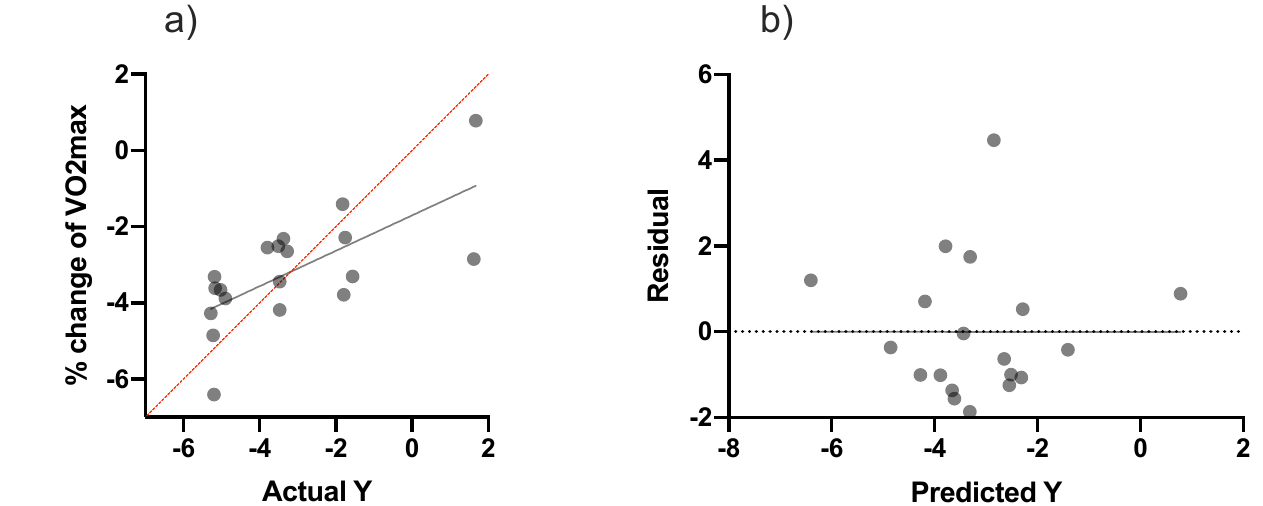
Figure 2. Multiple linear regression analysis was calculated to predict the percentage of change in fitness levels ( a ) VO 2max based on accumulated workloads. and PHV in the soccer players. Also. ( b ) residual plot was calculated to predict the percentage of change in VO 2max levels; the difference between the actual value of the dependent variable and the value predicted by the residual provided. PHV = Peak height velocity; VO 2max : maximum rate of oxygen consumption. In order to predict the percentage change in aerobic power based on PHV, multiple linear regression analyses were carried out (Table 5 and Figure 3). Aerobic power revealed that there were significant differences (F (3, 15) = 3.40, p = 0.04), with an R 2 value of 0.40. Participants showed good predictions for aerobic power; (Y) is equal to Beta0 + Beta1 (ACWR) + Beta2 (TM) + Beta3 (PHV).